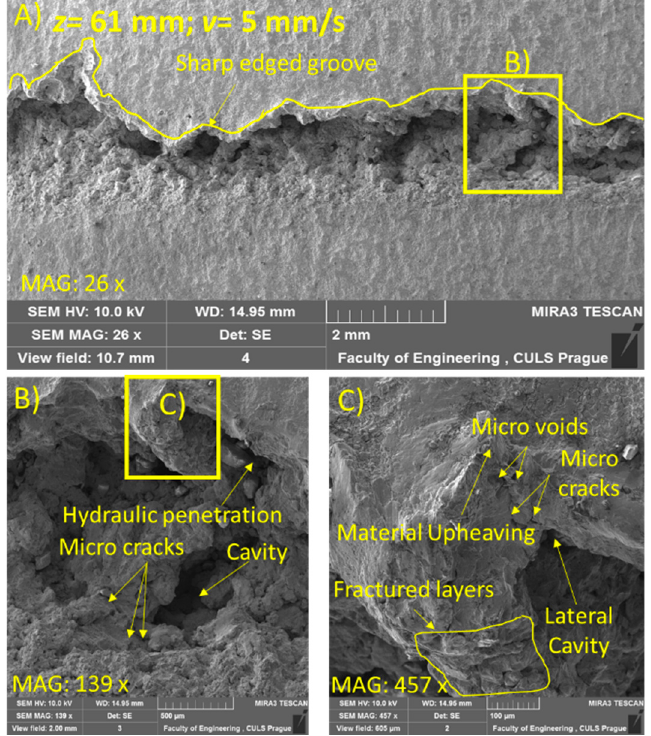
Figure 9. SEM image of sample subjected to p = 70 MPa, z = 61 mm, and v = 5 mm/s (A) at magnification 26×, (B) At magnification 139× and (C) At magnification 457×.